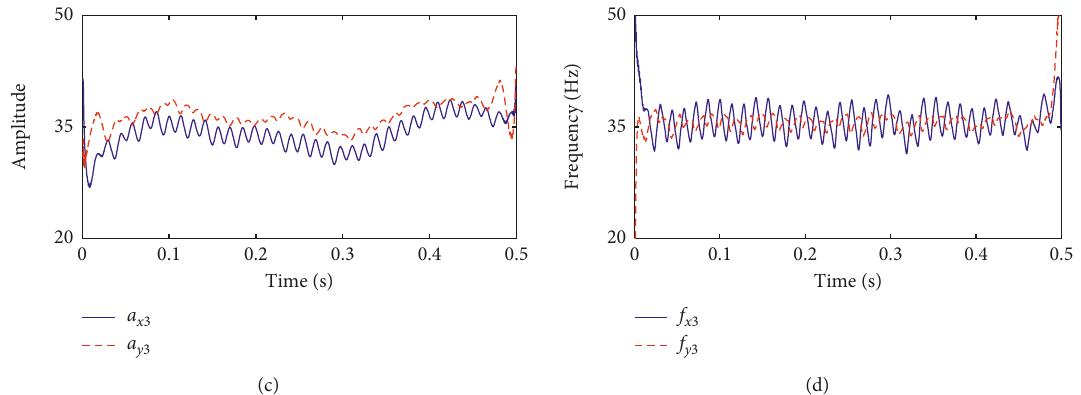
Figure 17: The instantaneous amplitude and frequency of c 2 and c 3 from the oil whirl signal obtained by the HT: (a) the instantaneous amplitude of the real part and imaginary part of c 2 ; (b) the instantaneous frequency of the real part and imaginary part of c 2 ; (c) the instantaneous amplitude of the real part and imaginary part of c 3 ; (d) the instantaneous frequency of the real part and imaginary part of c 3 .